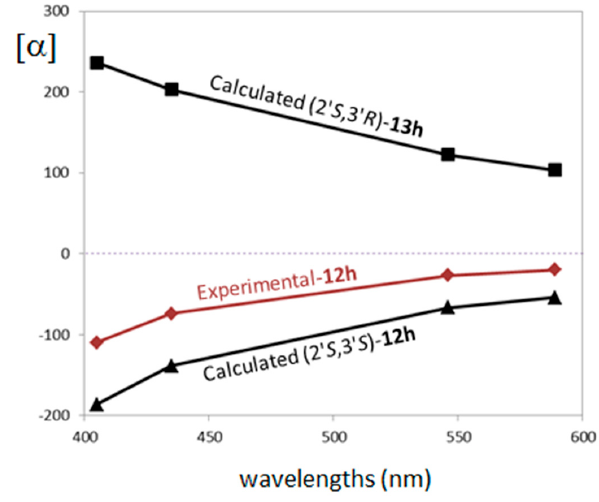
Figure 3 . Comparison of experimental and computed optical rotatory dispersion (ORD) spectra for the different ACs for compounds trans - 12h (experimental and calculated) and cis - 13h (calculated).